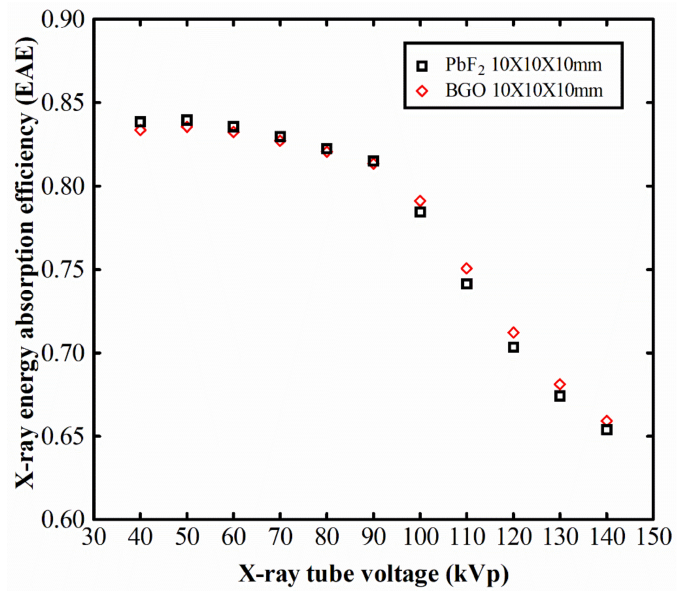
Figure 3. Energy absorption efficiency of PbF 2 and BGO.